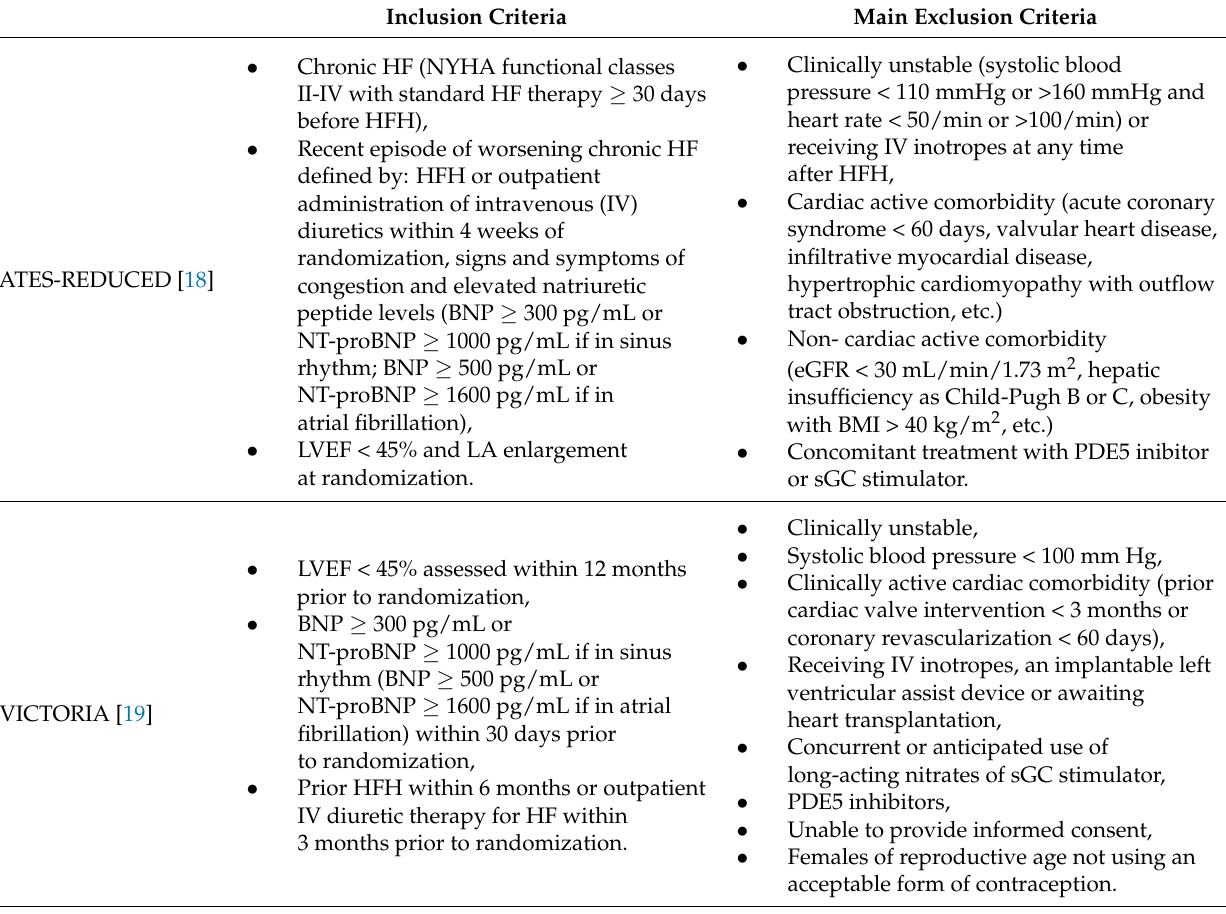
Table 1. SOCRATES-REDUCED and VICTORIA trials’ inclusion and exclusion